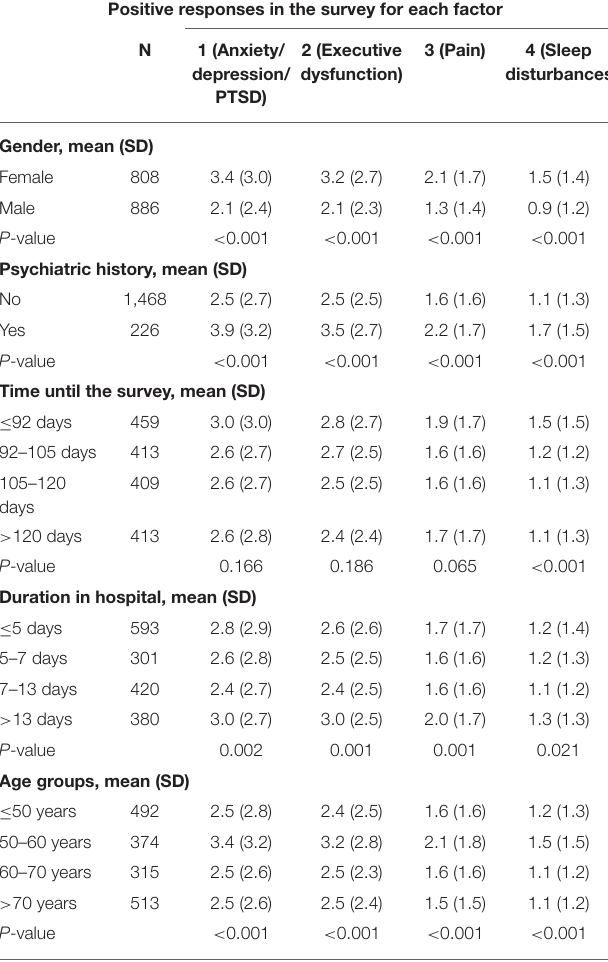
TABLE 5 | Association between patient’s risk factors and main factors identified in the principal component analysis. Positive responses in the survey for each